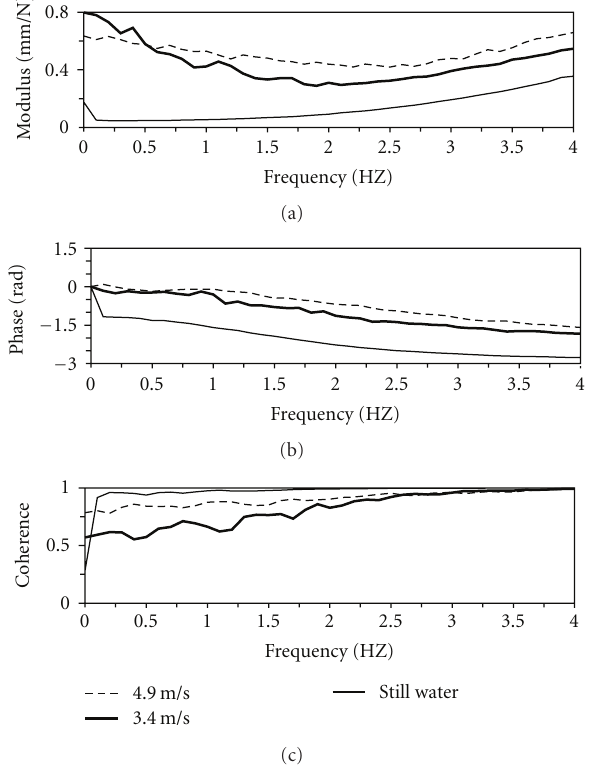
Figure 12: Transfer function H corner ( ω ); modulus versus frequency (a), phase versus frequency (b); coherence between f corner and u central versus frequency (c); in still water, and for 3.4m/s and 4.9m/s fluid